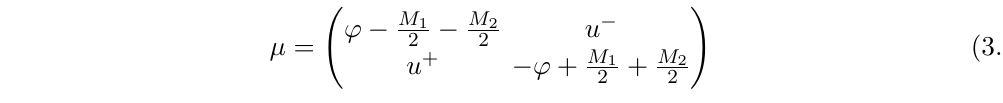
Figure 2 . SQED with 2